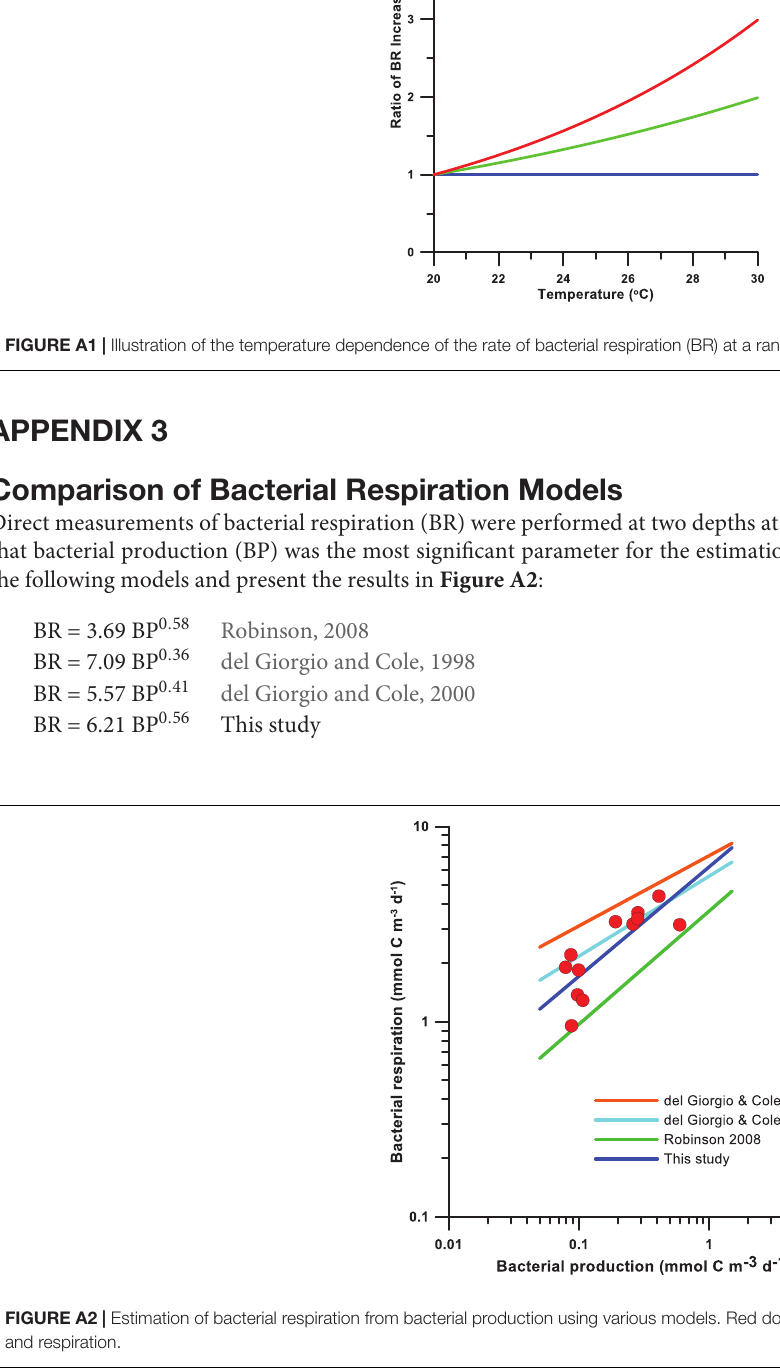
del Giorgio and Cole’s (2000) model tends to predict high BR values, while Robinson’s (2008) model gives low BR values. del Giorgio and Cole (1998) and our models’ predictions are similar and lie between the other two models.